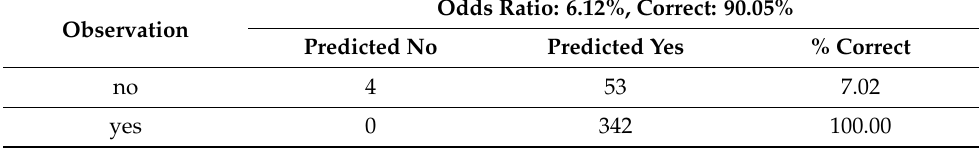
Table 7. Classification of cases—barriers to the application of healthy eating habits among young Poles.